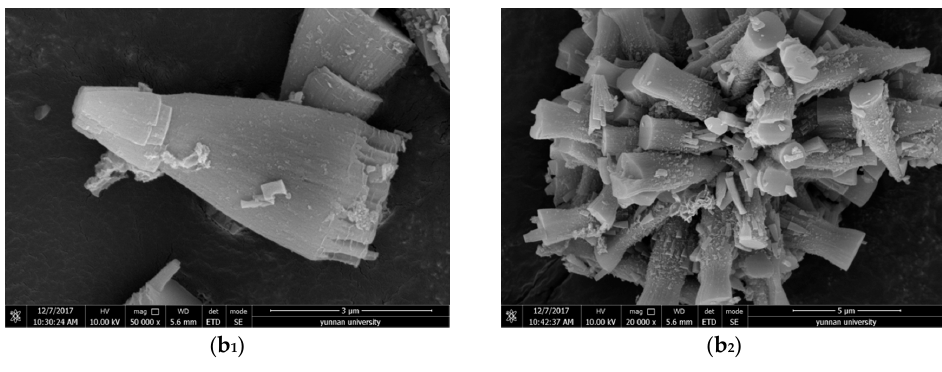
Figure 3. The SEM images of Cu(BDC-NH 2 )(DMF) ( a 1 , a 2 ) and Et- N -Cu(BDC-NH 2 ) (DMF) ( b 1 , b 2 ).